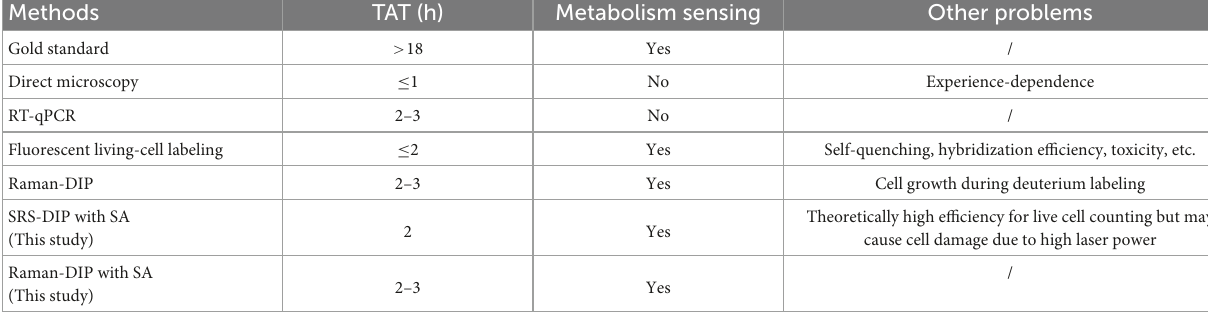
TABLE 1 Comparison of the current cell-counting methods. Methods Metabolism